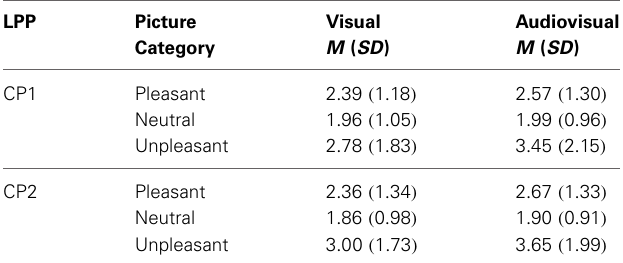
Table 4 | Mean and standard deviation for the late positive potential (LPP) on CP1 and CP2 in response to visual and audiovisual presentations separately for pleasant, neutral and unpleasant